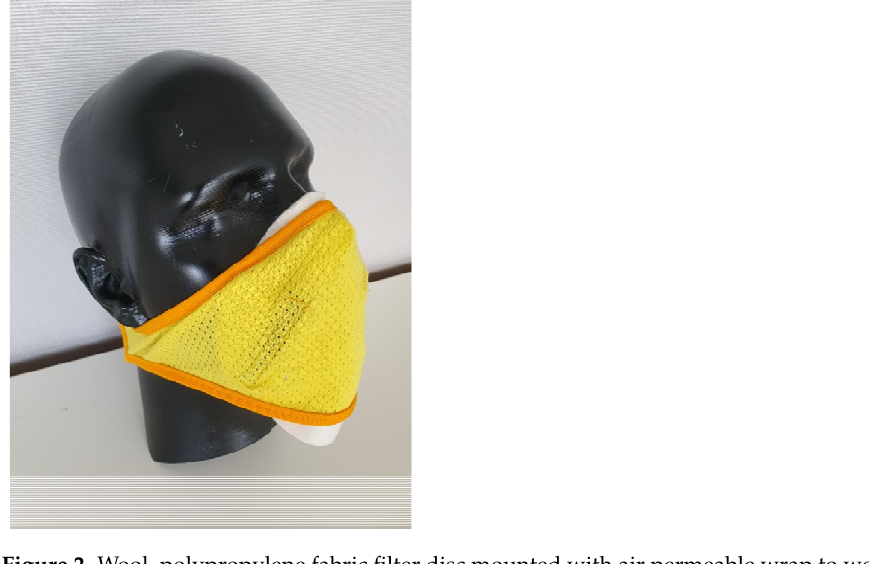
Figure 2. Wool–polypropylene fabric filter disc mounted with air permeable wrap to wearer’s face.